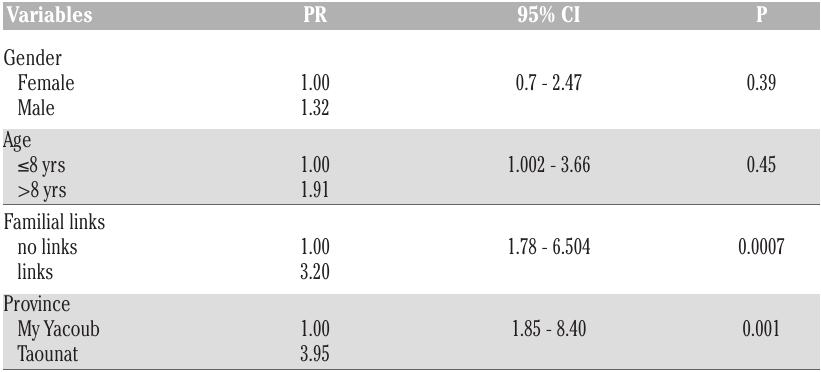
Table 3. Association between nodule size and gender, age, familial links and province. Prevalence ratios (PR) and their 95% confidence intervals (95% CI).